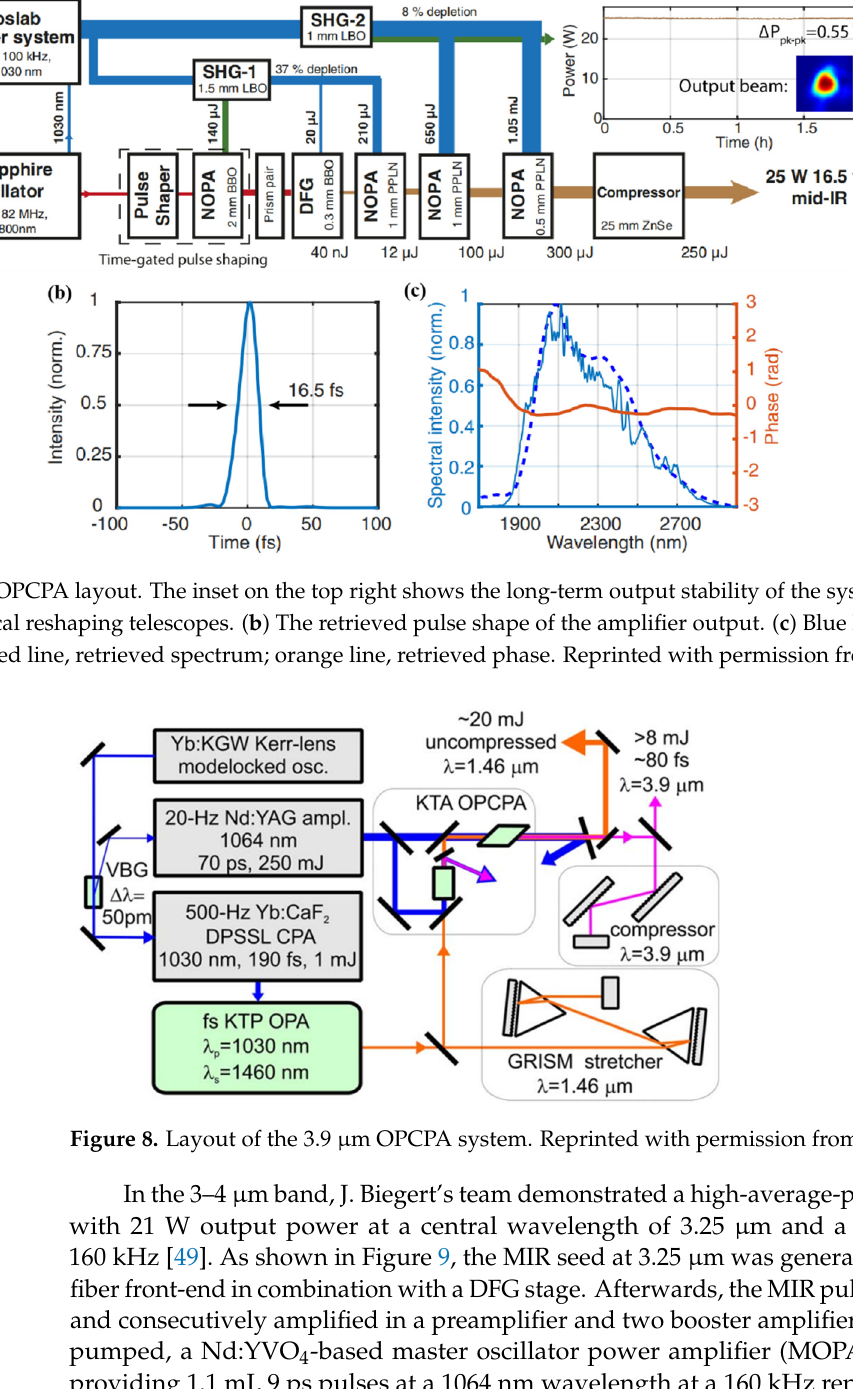
nance photonic crystal fiber, yielding 14.5 fs pulses at 3.3 μ m with a 9.6 W average power.